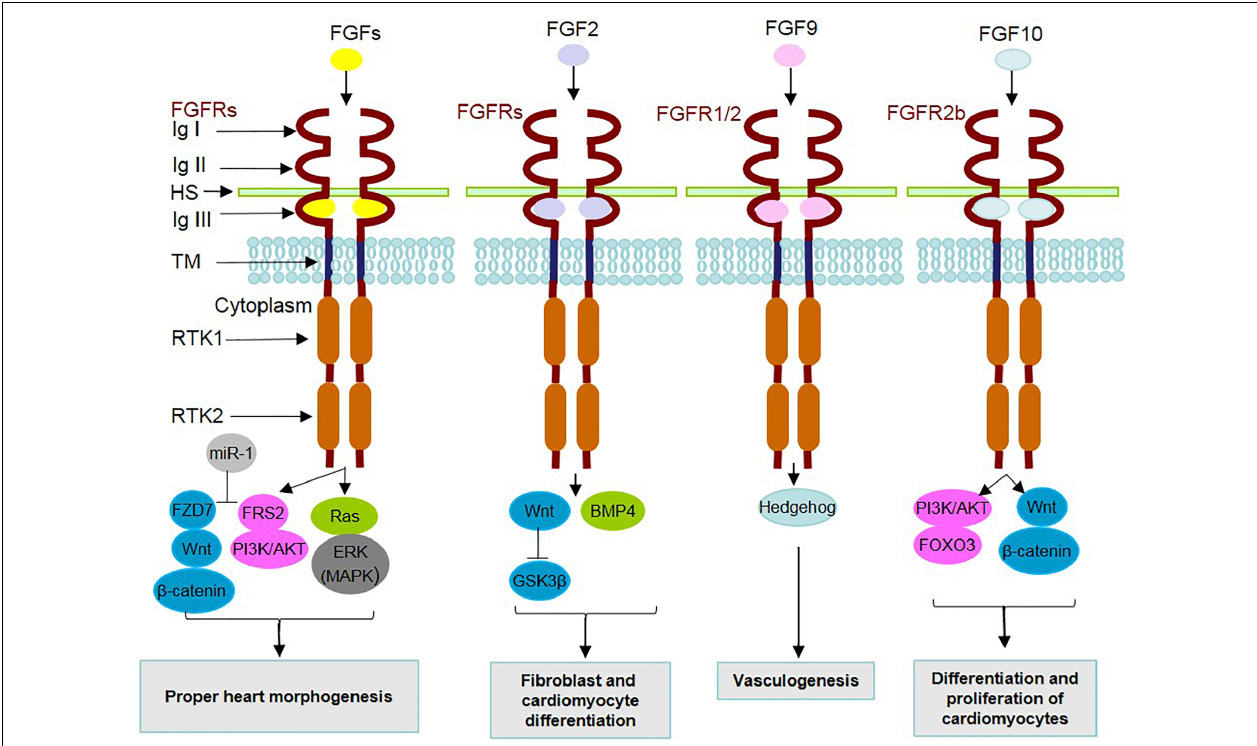
FIGURE 1 | Mechanism of action of secreted FGFs and identified underlying signaling contributors in heart development. During heart development, FGF ligands, through binding to FGF receptors (FGFRs) and cofactors [such as heparan sulfate (HS)] and dimerization, contribute to the activation/inhibition of related underlying intracellular signaling pathways. The FGFR family is composed of 7 FGFRs encoded by 4 genes expressing the alternative splicing forms 1b, 1c, 2b, 2c, 3b, 3c, and 4. FGFRs contain extracellular immunoglobulin-like domains (Ig I–III), a transmembrane domain (TM) and receptor tyrosine kinase domains (RTKs 1 and 2). MicroRNA-1 (miR-1) is positively involved in FGF actions through inhibition of FRS2 and FZD7. A summary of the effects related to the interactions of FGFs with underlying signaling mediators in cardiac development is listed in the